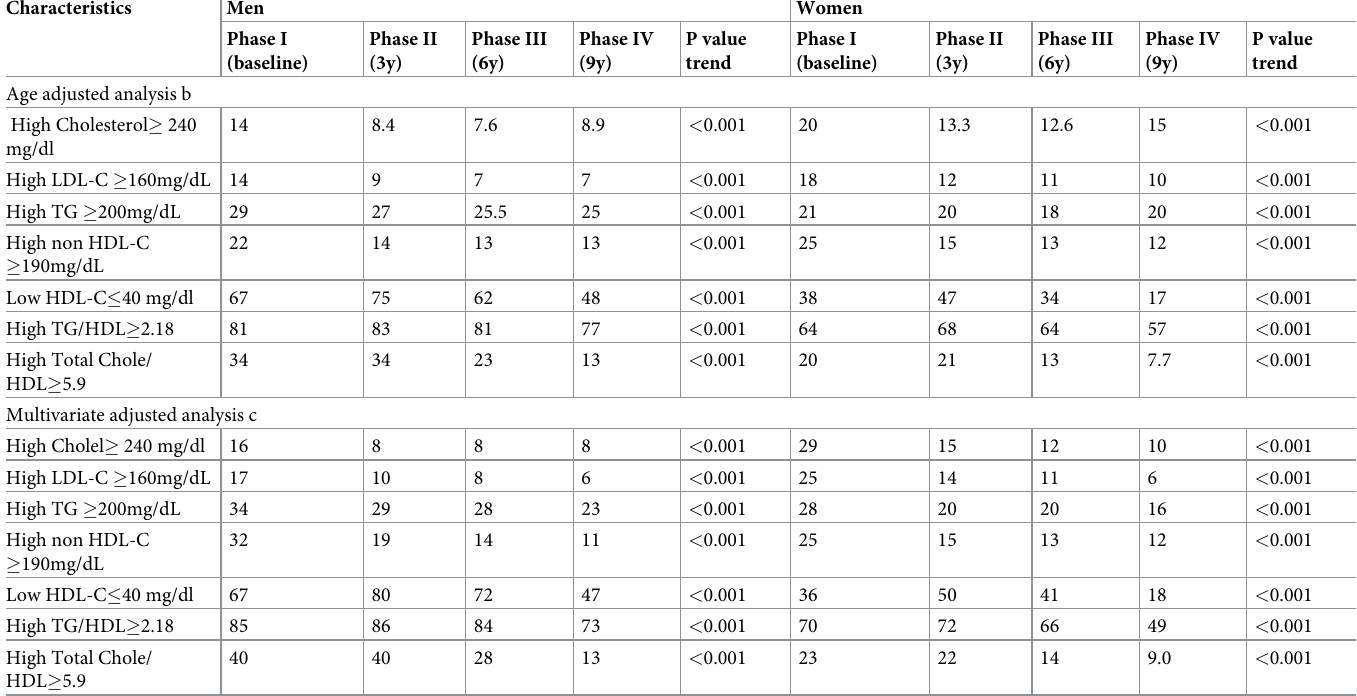
Table 4. Proportions of Participants in various Categories of dyslipidemia in baseline and 3, 6,9years after follow up.